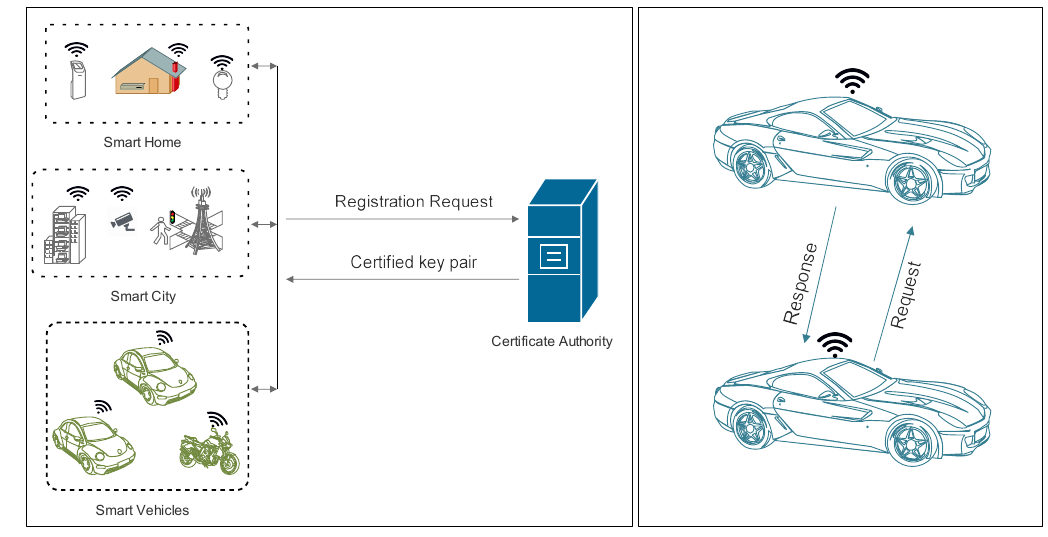
Figure 1. Device to Device Authentication